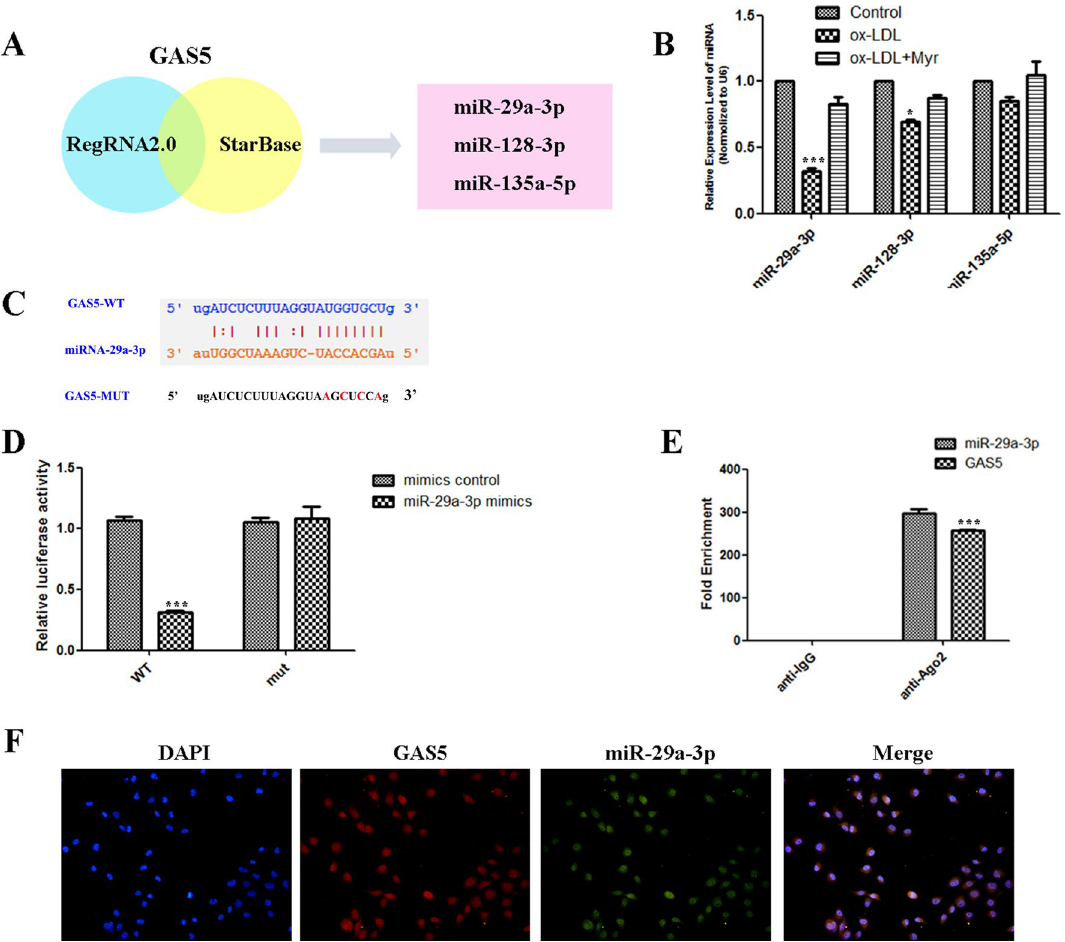
Figure 4. miR-29a-3p is a target of GAS5 in HUVEC. ( A ) Bioinformatics analyses including RegRNA2.0 and StarBase were used for prediction. ( B ) Three microRNAs were identified, including miR-29a-3p, miR-128-3p and miR-135a-5p. ( C ) The predicted binding between GAS5 and miR-29a-3p. ( D ) Dual-luciferase reporter assay validating the interaction between GAS5 and miR-29a-3p. ( E ) RIP assay and qRT-PCR were conducted to detect the enrichment of GAS5 and miR-29a-3p by using AGO2 antibodies in HUVEC cells. ( F ) RNA FISH for GAS5 and miR-29a-3p was detected in HUVEC cells, miR-29a-3p was co-localized with GAS5 in the nucleus (magnification, ×400). Nuclei were stained blue (DAPI), GAS5 was stained red, miR-29a-3p was stained green. * P < 0.05, ** P < 0.01, *** P <